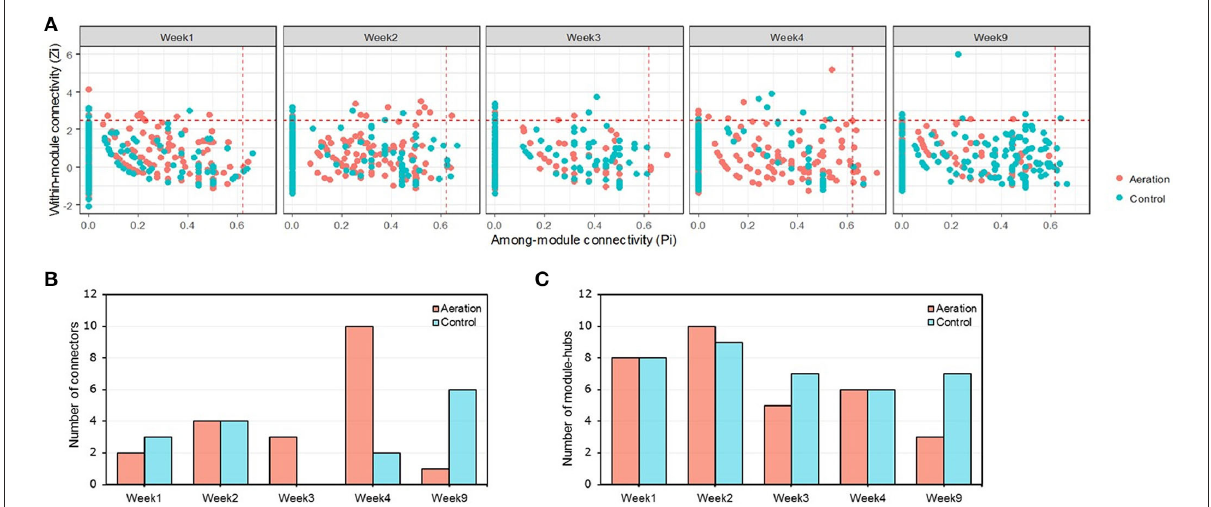
FIGURE4 ZP plot of temporal pMENs showing the distribution of nodes based on their within-module ( Z i ) and among-module ( P i ) connectivity (A) together with the numbers of keystone nodes, including connectors (B) and module hubs (C) . Two nodes (ASV_144, member of family Sphingomonadaceae, and ASV_572, member of family Pedosphaeraceae ) were classified as network hubs present in the control Week 9 and aerated Week 2 pMENs.